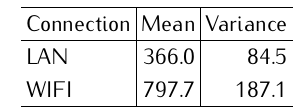
Table 1. Time delay in the camera-arm cycle of NAO (in